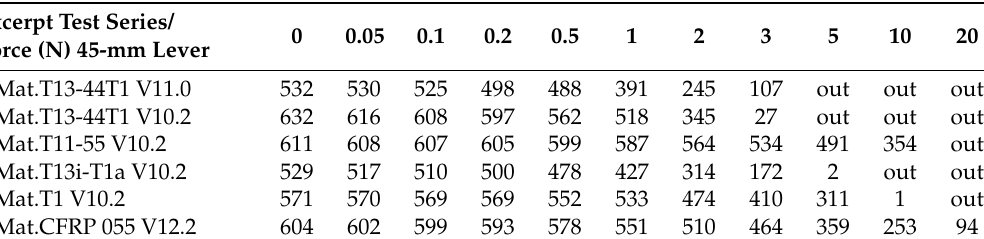
Table 1. Selected measurements with different materials and versions.